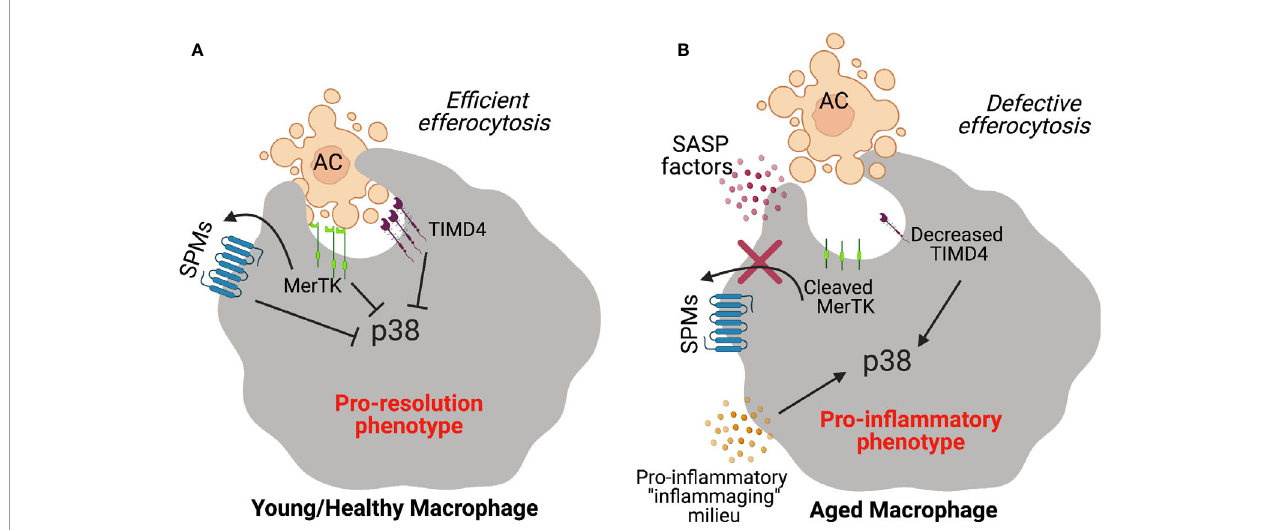
FIGURE 1 | Schematic diagram depicting failed efferocytosis mechanisms during aging. (A) Efferocytic receptors like MerTK or TIMD4 on young healthy macrophages interact with phosphatidyl serine on apoptotic cells to promote ef fi cient clearance. SPMs promote efferocytosis and MerTK signaling in a feed forward manner which stimulates the synthesis of SPMs. In response to apoptotic cell ingestion, the pro-in fl ammatory p38 MAPK pathway is inhibited and macrophages prevent the production of pro-in fl ammatory programs. (B) In the context of aging, MerTK is cleaved by released factors from senescent cells (i.e. factors from the senescence-associated secretory phenotype or SASP) which limits apoptotic cell uptake and the feed-forward pro-resolution circuit. TIMD4 expression is also signi fi cantly decreased on macrophages from aging humans which drives the activation of p38 to propagate in fl